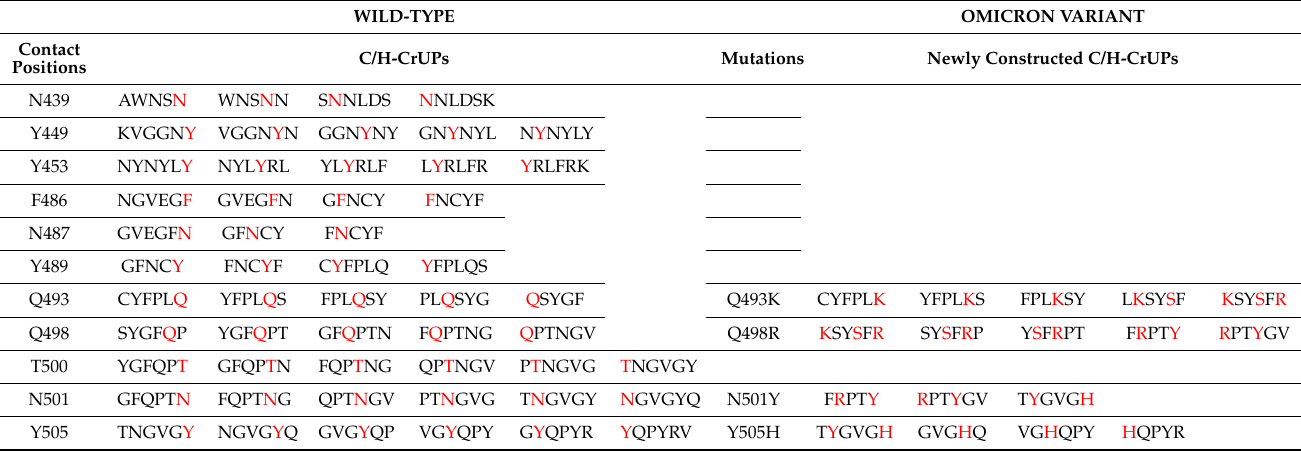
Table 3. C/H-CrUPs around SARS-CoV-2 RBD contact